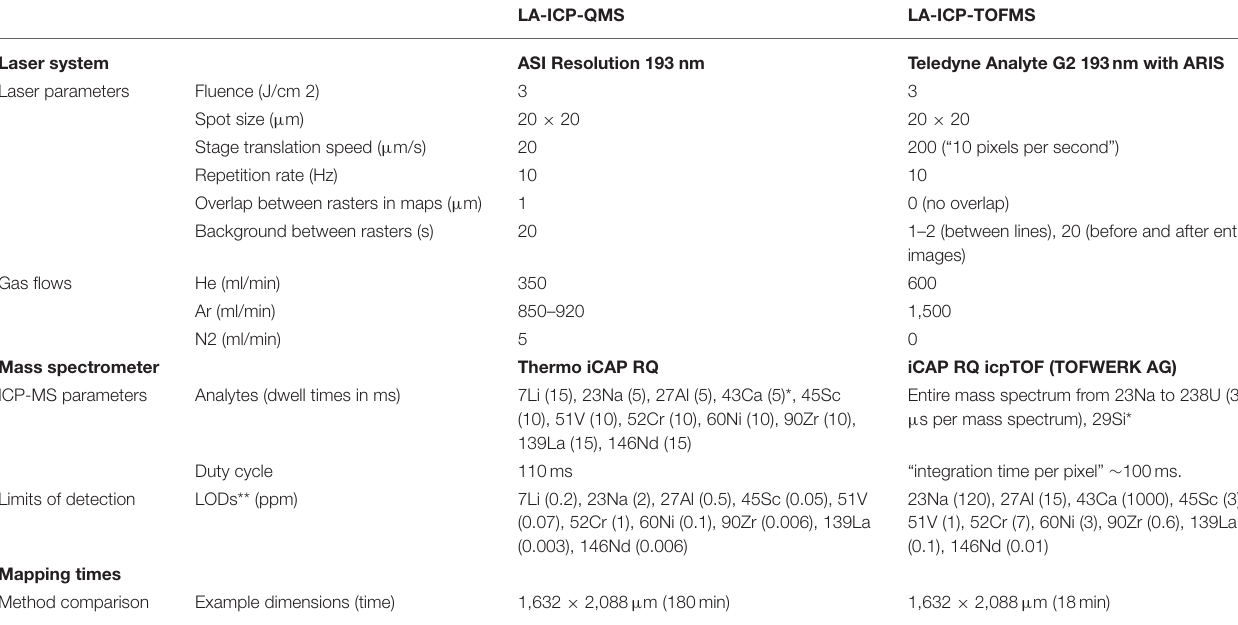
TABLE 1 | Instrument parameters used for laser ablation micro-chemical mapping